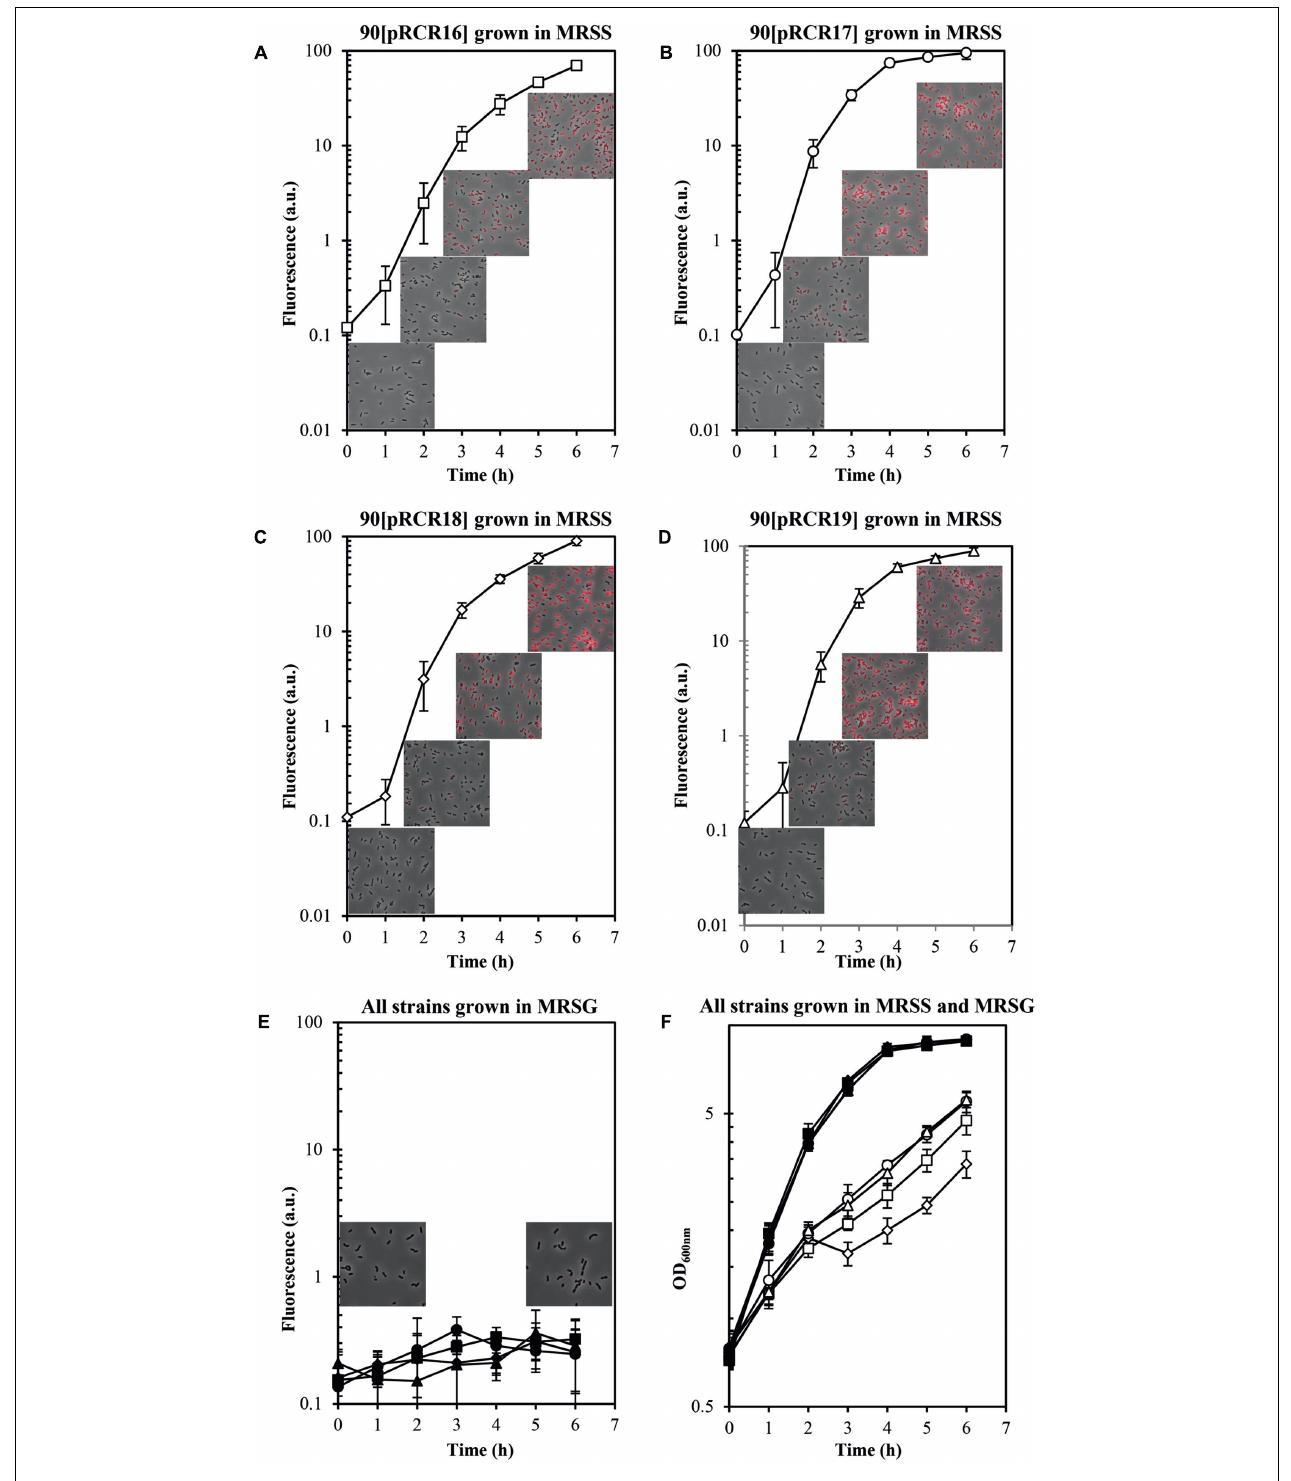
FIGURE 8 | Trans complementation of the sorbitol utilization regulatory machinery in L. plantarum 90. Bacteria carrying (A,E,F) pRCR16 ( (cid:3) , (cid:4) ), (B,E,F) pRCR17 ( ), (C,E,F) pRCR18 ( ♦ , (cid:7) ) or (D,E,F) pRCR19 ( (cid:52) , (cid:78) ) were grown in MRSG and at time 0 were transferred to fresh MRSS (open symbols) or to MRSG (closed symbols). OD 600 nm and fluorescence of the cultures were monitored every hour. Overlays of images of the cultures taken at time 0 and after 2, 4, and 6 h incubation by phase contrast and fluorescent microscopy are depicted. The experiments were performed in triplicate and the mean value and standard deviation is depicted.